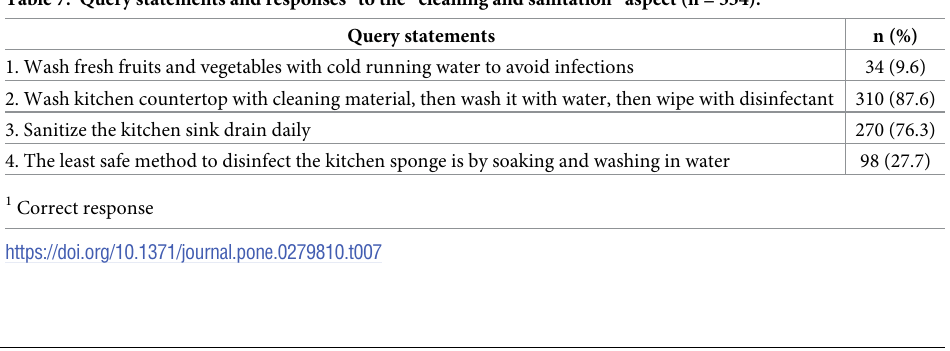
Table 7. Query statements and responses 1 to the “cleaning and sanitation” aspect (n =